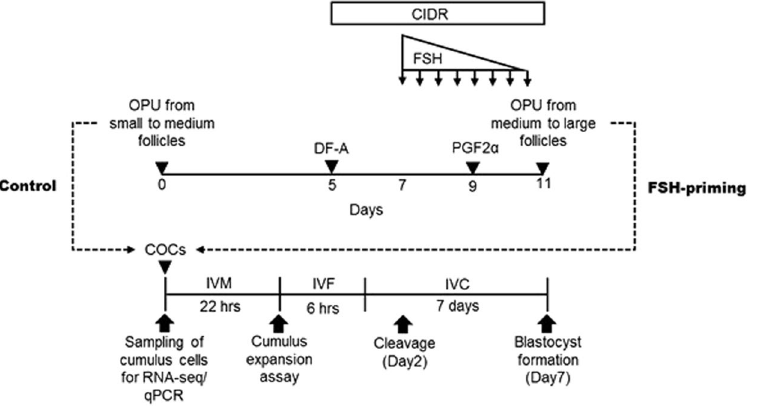
Figure 7. Schematic representation of experimental design. The first OPU from small to medium follicles was performed on unstimulated animals on arbitrary days of the oestrus cycle (control). Then, follicles larger than 8 mm in diameter were ablated (DF-A), and CIDRs were inserted on day 5 (the day of first OPU = day 0). The cows then received 30 mg FSH twice a day from days 7 to 10, in decreasing doses (6, 6, 4, 4, 3, 3, 3, and 2 mg) by intramuscular injection. Cloprostenol (PGF2 α ; 0.75 mg) was administered in the morning of day 9. The second OPU was performed 48 h after PGF2 α administration (day 11), and only follicles larger than 5 mm in diameter (medium and large) were aspirated. CIDRs were removed from cows just before OPU (FSH-priming). COCs of only morphological category A and B were used for investigating cumulus expansion and